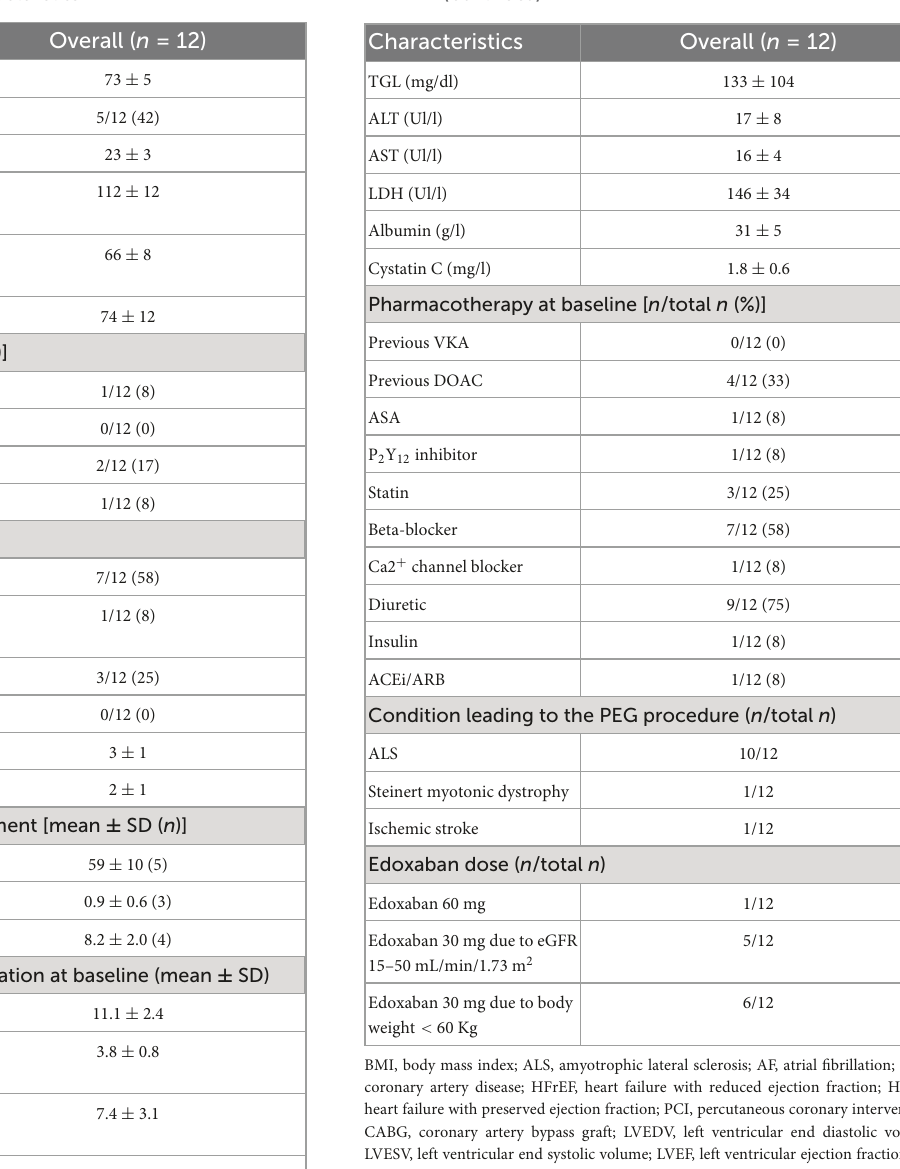
Direct Oral Anticoagulants (13) and its recent update (14), despite evidence about a precise therapeutic range for edoxaban are lacking (15). The mean plasma concentration was 208.5 Five patients died during follow-up: one died at a 1-month follow-up due to acute respiratory failure, and one died at a 6-month follow-up due to acute respiratory failure. Three patients died during the 12-month follow-up period due to acute respiratory failure, sepsis, and intestinal occlusion ( Figure 4 ), respectively. All five deaths were related to